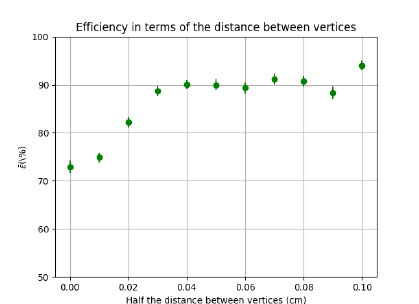
Figure 3: Plots for two di ff erent distributions of